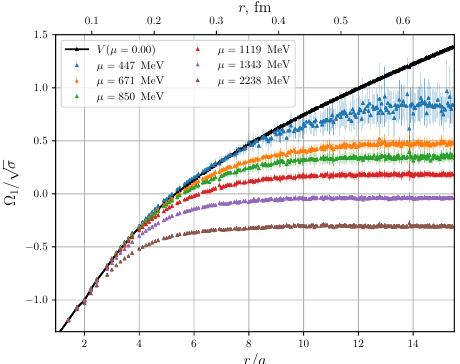
Figure 2 . The color singlet grand potential as a function of distance for few values of the chemical potential under study. The black curve is the potential of a static quark-antiquark pair at zero density and temperature. Note the absence of a Coulombic small distance regime, due to smearing.